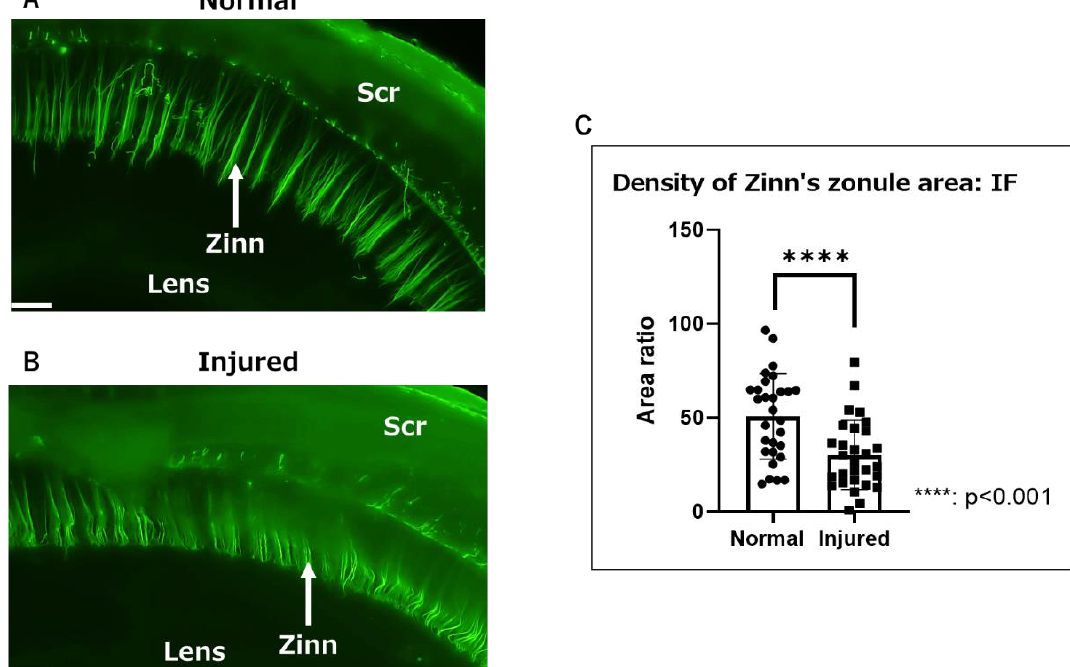
Figure 1. Macroscopic observation of Zinn’s zonule in gel-embedded specimens. ( A , B ) Fluorescence images (magnified 40 × ) of Zinn’s zonule in a rat eye. Zinn’s zonule was stained with anti-MAGP1 (green). ( A ) Zinn’s zonule was clearly visible in the normal group in a three-dimensional view. ( B ) The background staining was stronger and Zinn’s zonule was deflected in the injured group. ( C ) The MAGP1-positive area was measured for 6–8 microscopic fields per specimen. The ratio of Zinn’s zonule area over the area between the lens and scleral wall was calculated to normalize the individual differences among specimens. There was a significant decrease in the fluorescence-positive area in the injured group. Four rat specimens were imaged for the normal and injured groups and the entire Zinn’s zonule was analyzed, for both groups. Zinn: Zinn’s zonule, Scr: sclera, IF: immunofluorescence. Scale bar: 200 μm.